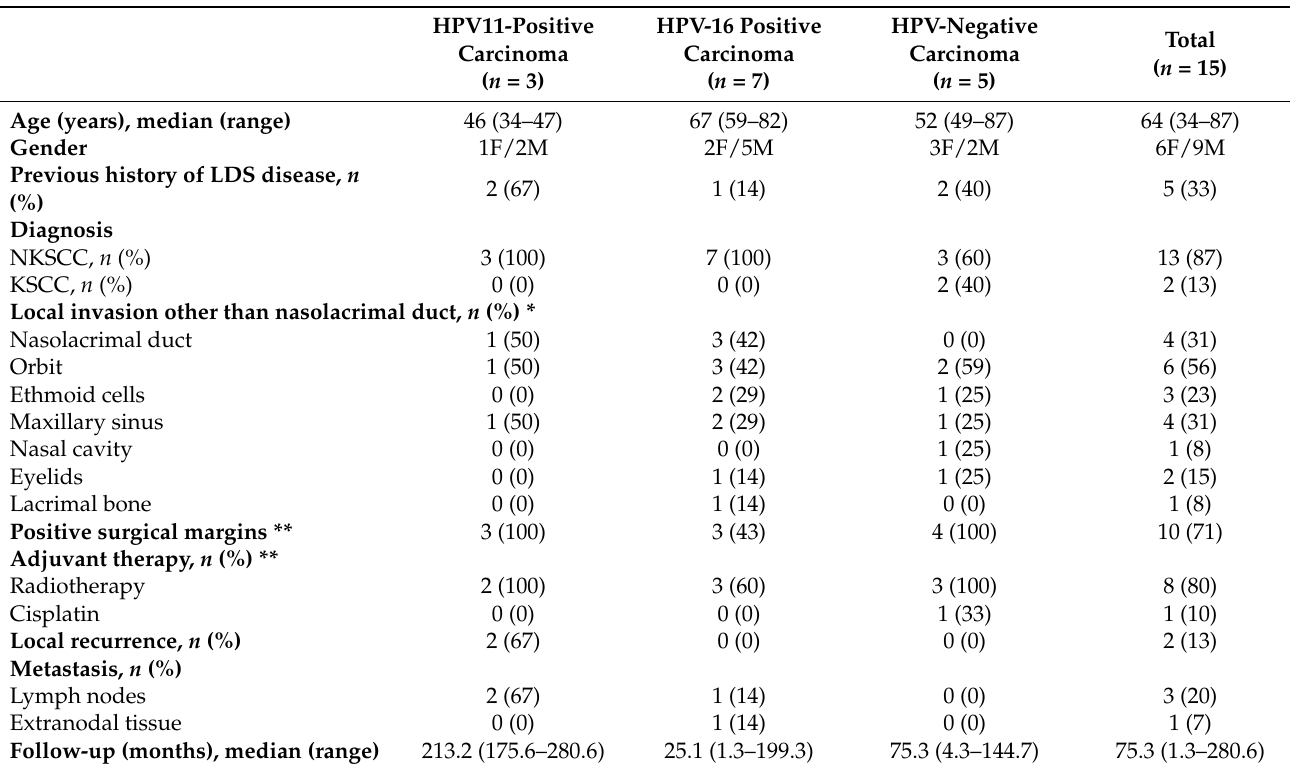
Table 1. Baseline characteristics of patients with a squamous cell carcinoma of the lacrimal drainage system (LDS) in a Danish cohort. HPV; human papillomavirus, M; male, F; female, NKSCC; non- keratinizing squamous cell carcinoma, KSCC; keratinizing squamous cell carcinoma, RT; radiotherapy. * Several patients had multifocal disease. ** Data was missing in some